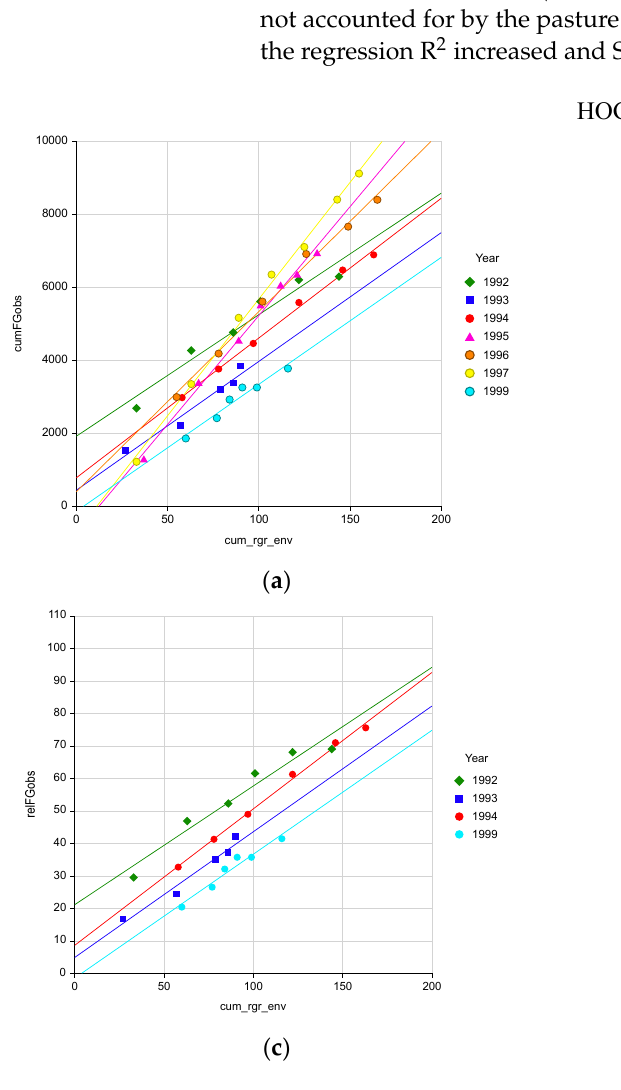
Figure 1. ( a ) Accuracy of the pasture growth model’s cumulative relative growth rate due to environment (cum_rgr_env) describing cumulative forage growth observed (cumFGobs, kg/ha) and ( b ) cumulative relative forage growth observed (relFGobs) at the HOG location over seven years with ( c ) years showing individual year effects (different intercepts) and ( d ) years showing a consistent proportional effect (different slope).